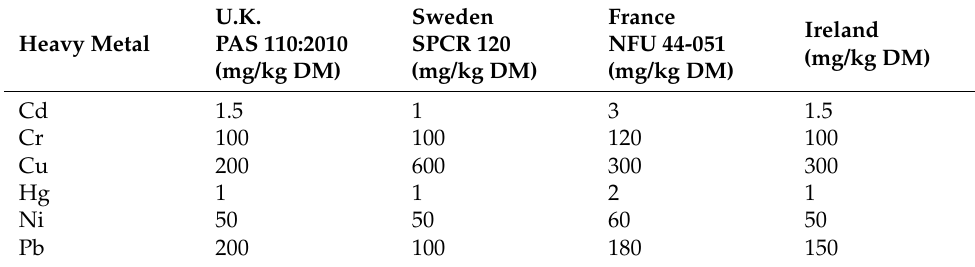
Table 3. Biofertilizer standards from some European countries. Heavy